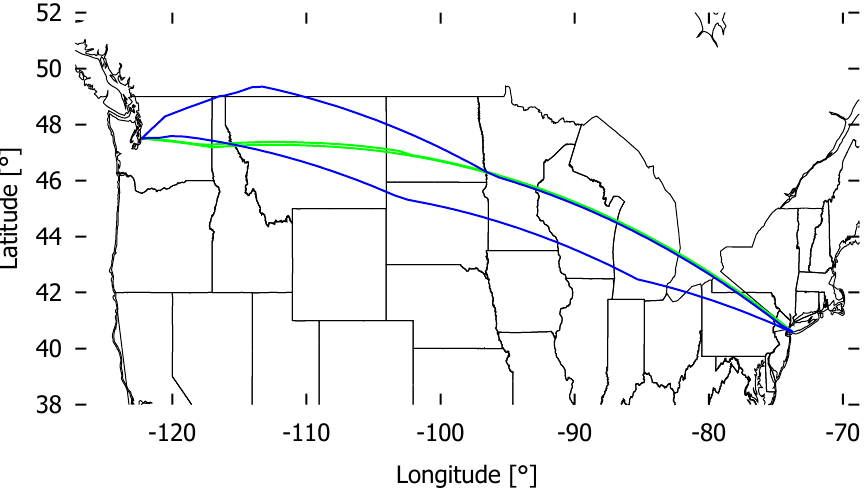
Figure 12. Plot of the smallest (29th, green) and largest (31st, blue) CoO by area in January 2020 for the flight KSEA-KJFK, 12:00 a.m. UTC departure